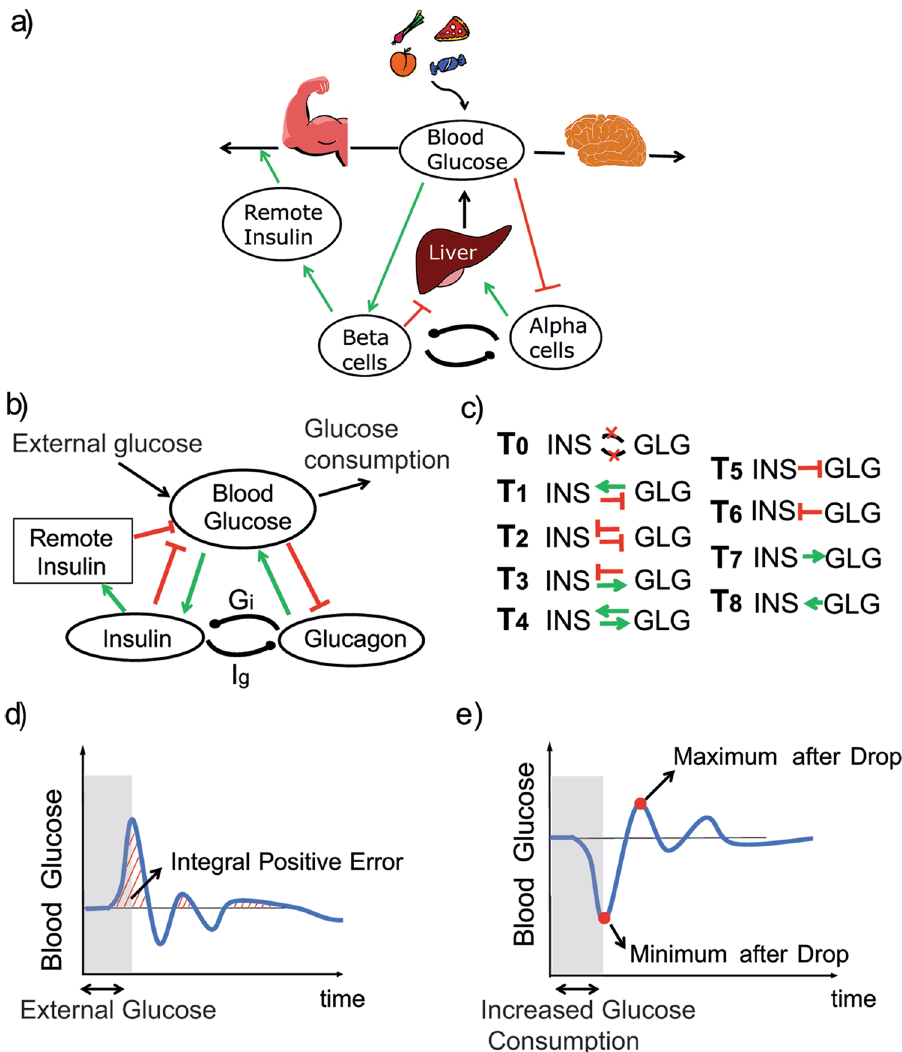
Figure 1. The intra-islet network and alpha and beta cell interactions. ( a ) Scheme for the blood glucose homeostasis mechanism: alpha and beta cells mediate two negative feedback loops with glucose through the liver’s glucose production. Remote insulin promotes the uptake of glucose from the blood by muscles and bones, thus decreasing its level; brain asserts a constant blood glucose consumption; food represents an external source of glucose. ( b ) Scheme for the intra-islet topology: green arrows represent activating interactions, red arrows are inhibitory interactions. Insulin and glucagon affect each other's secretion with strengths I g and G i respectively; external glucose represents meals, glucose consumption represents exercise. ( c ) All possible combinations of paracrine interactions: topology T 0 has no direct interaction between the hormones ( I g = G i = 0); T 1 − T 4 are topologies with both nonzero interactions ( I g ≠ 0 and G i ≠ 0); T 5 − T 8 are topologies with only one nonzero interaction ( I g ≠ 0 or G i ≠ 0); ( d ) Blood glucose response to external glucose; the deviation from the steady state value is scored by the Integral Positive Error; ( e ) Blood glucose response to an increase in systemic glucose consumption; the deviation from the steady state value is scored by the minimum level after the drop and the first maximum overshoot after glucose reversion to steady